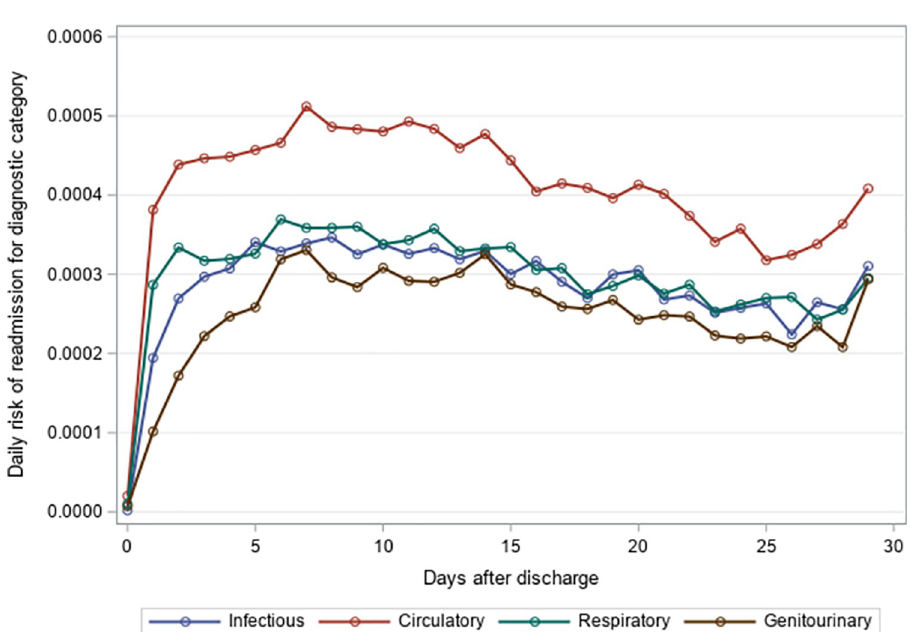
Fig 4. Daily risk of 30-day unplanned hospital readmission among older adults discharged to skilled nursing facilities following an index hospitalization for sepsis, 2012–2013. Presents the daily risk of unplanned hospital readmission for four common causes of readmission (infectious, respiratory, circulatory, genitourinary). Each year started on the Sunday of Morbidity and Mortality Weekly Report week 27 and ended on the Saturday of Morbidity and Mortality Weekly Report week 26 of the following